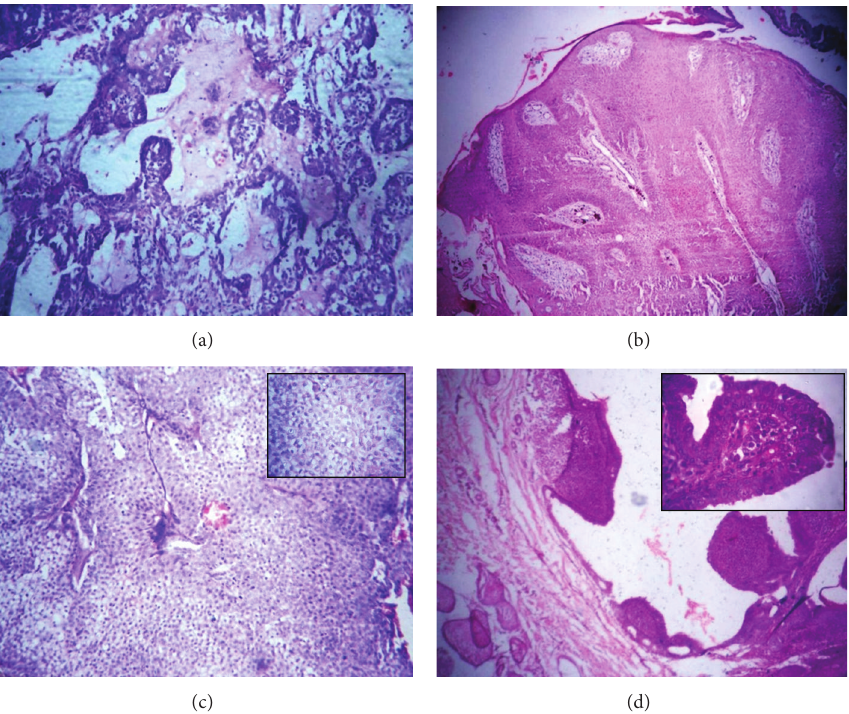
Figure 1: (a) Chondroid syringoma: tubular or ductular proliferation admixed with a chondroid stromal matrix. (H&E × 100). (b) Eccrine poroma: well-circumscribed tumor arising from lower portion of the epidermis extends downwards into dermis as cords and broad columns of uniform basaloid cells (H&E × 100). (c) Hidradenoma: Well-circumscribed nonencapsulated multilobulated tumor lobules with varying size and shape (H&E × 100), consisting of polyhedral cells with round nuclei with slightly basophilic cytoplasm and round cells with clear cytoplasm with small dark nuclei (Inset H&E × 400). (d) Syringocystadenoma papilliferum: epidermis with papillary projections extend into the lumina of the cystic invaginations. (H&E × 100) and the luminal row of high columnar cells with oval nuclei and faintly eosinophilic cytoplasm (Inset H&E × 400).